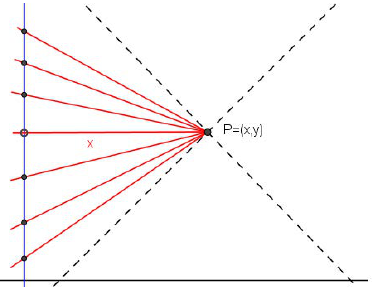
Fig. 4. Timelike geodesics in L 2 passing through P